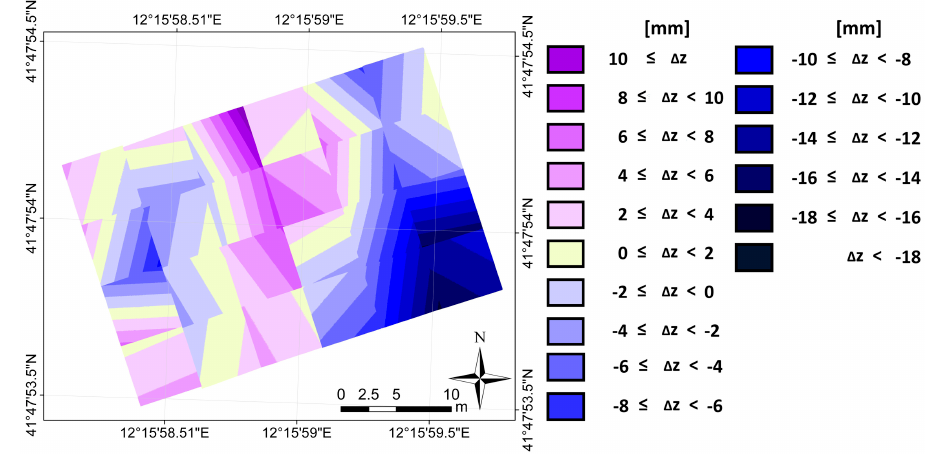
Figure 8. Faulting’s graphical display.